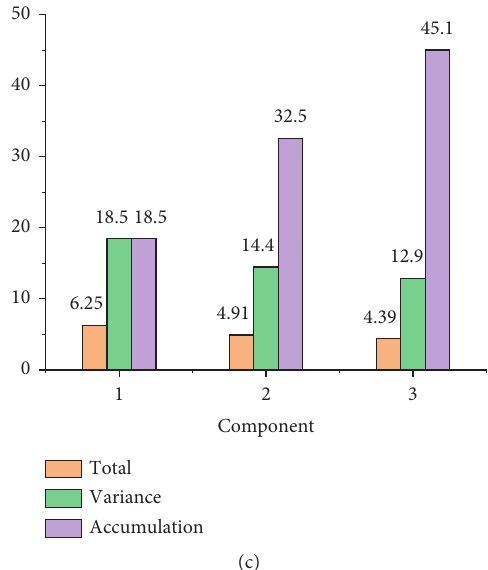
Figure 11: The total variance data of the construction risk index situation are as follows: (a) the initial feature value; (b) the extraction of the sum of squares and loaded; (c) the rotation of the sum of squares and